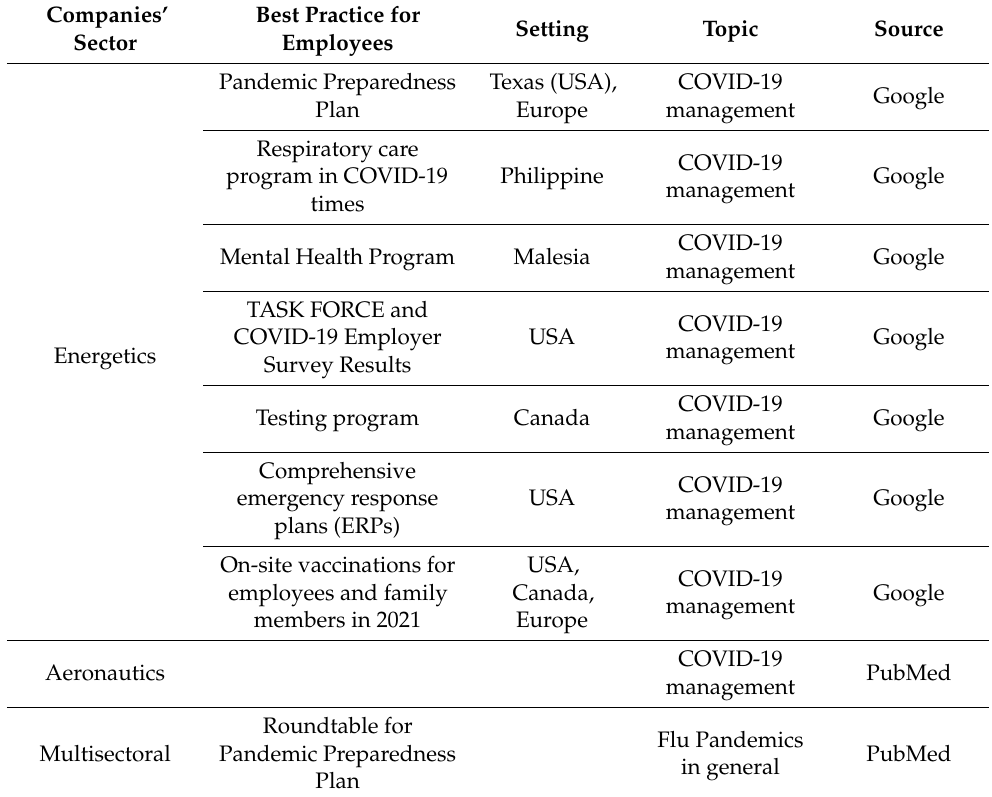
Table 2. Best practices: strategies and